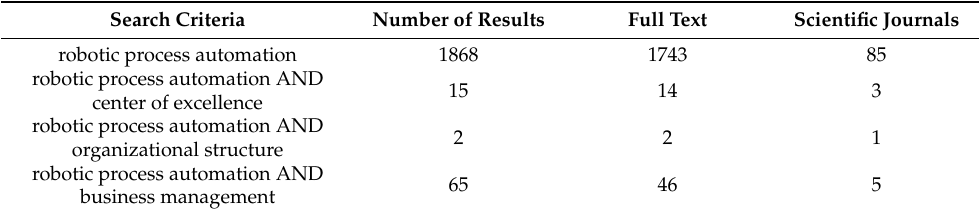
Table 3. Keywords used in EBSCO